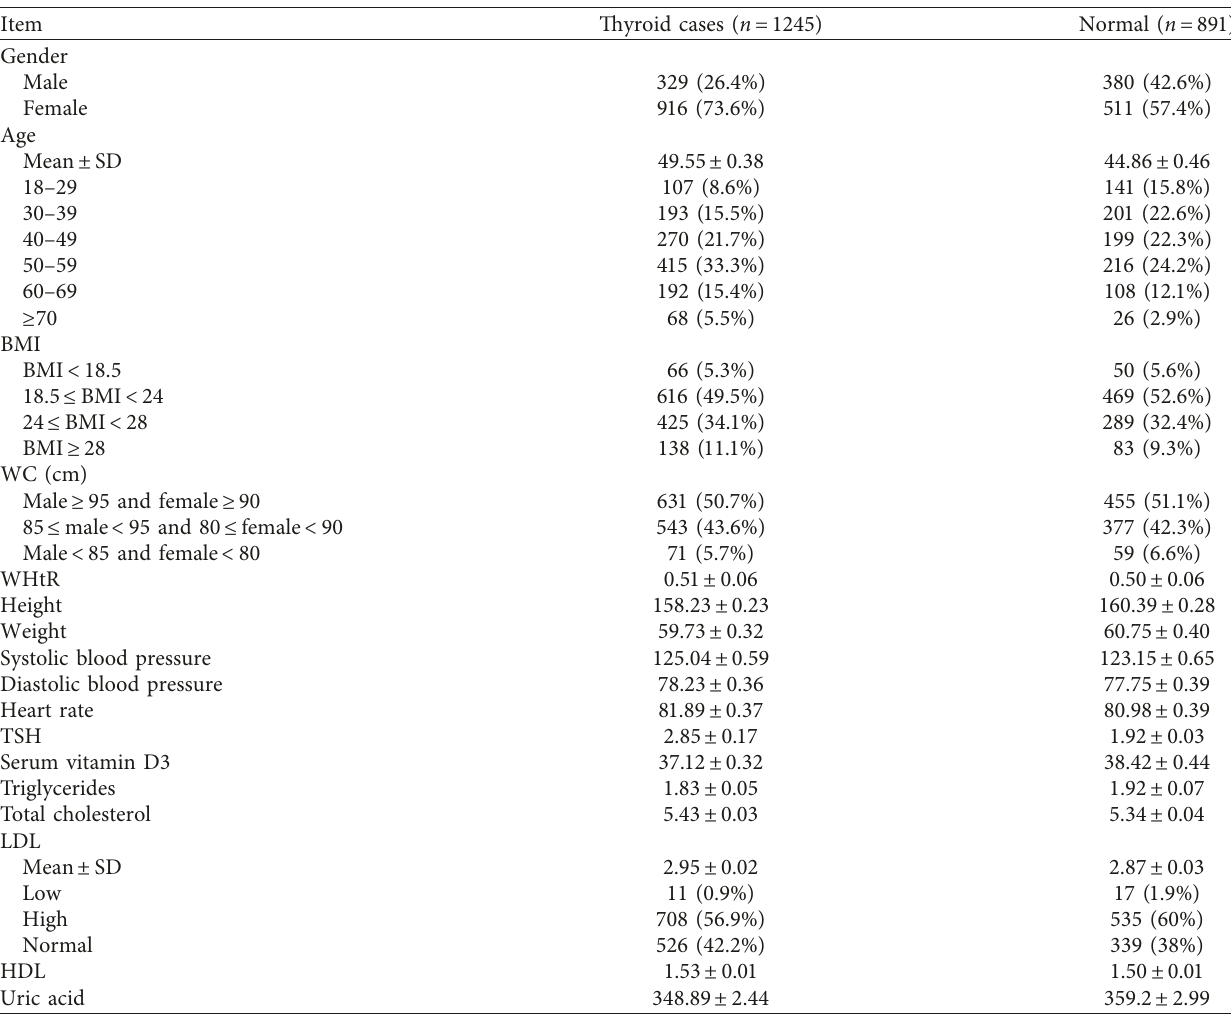
Table 1: Characteristics of subjects.